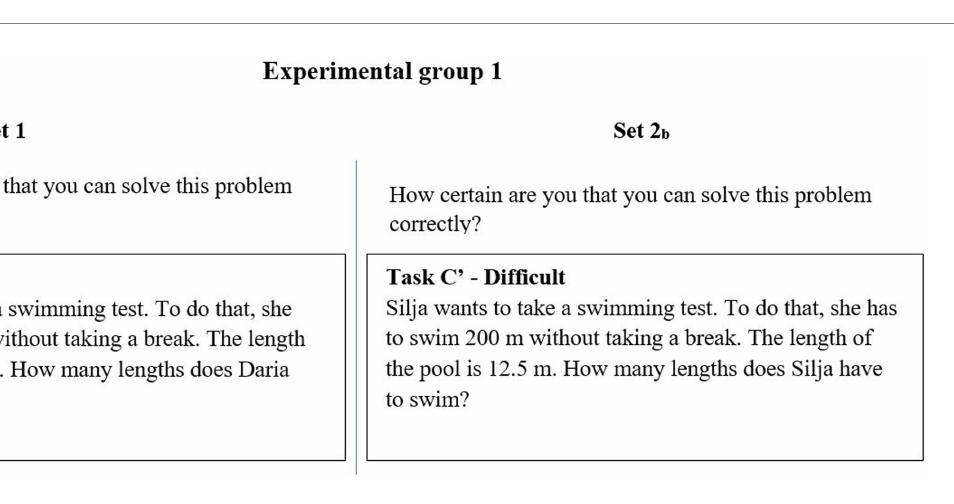
FIGURE 3 An example of how Task C appears for EG 1 (translated by the first